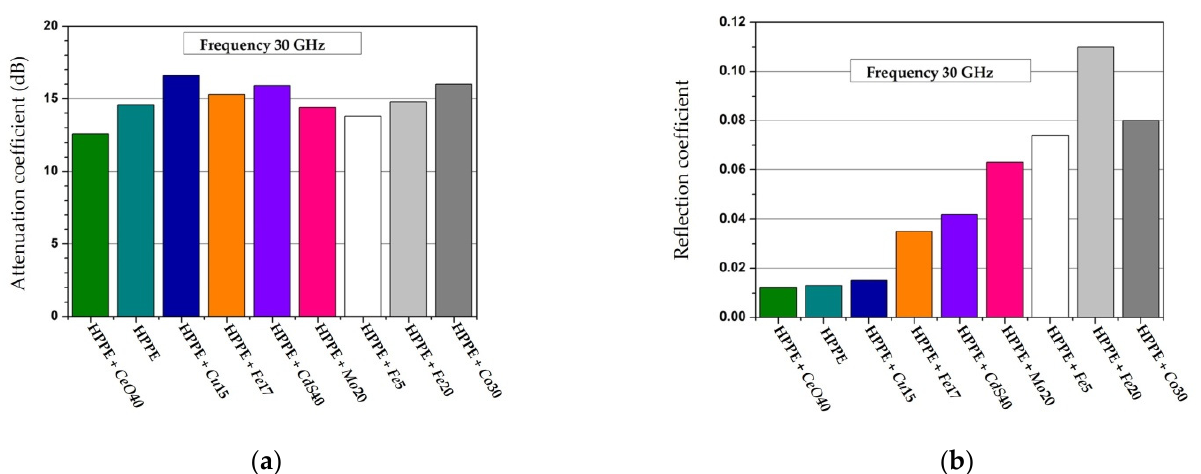
Figure 34. ( a ) Attenuation coefficient and ( b ) reflection coefficients of two-layer combinations of samples of composite materials based on metal-containing nanoparticles.